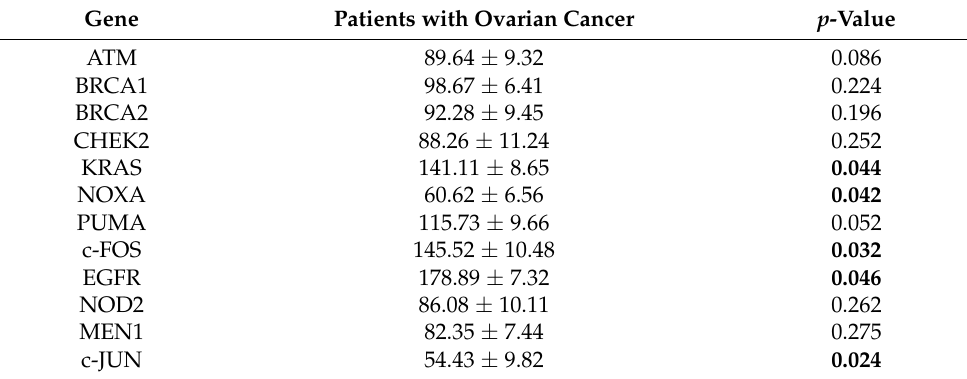
Table 4. Analysis of the protein level for ATM, BRCA1, BRCA2, KRAS, c-JUN, c-FOS, NOXA, PUMA, MEN1, NOD2, CHEK2, and EGFR in the tissue homogenates in patients with ovarian cancer in comparison to the control group.